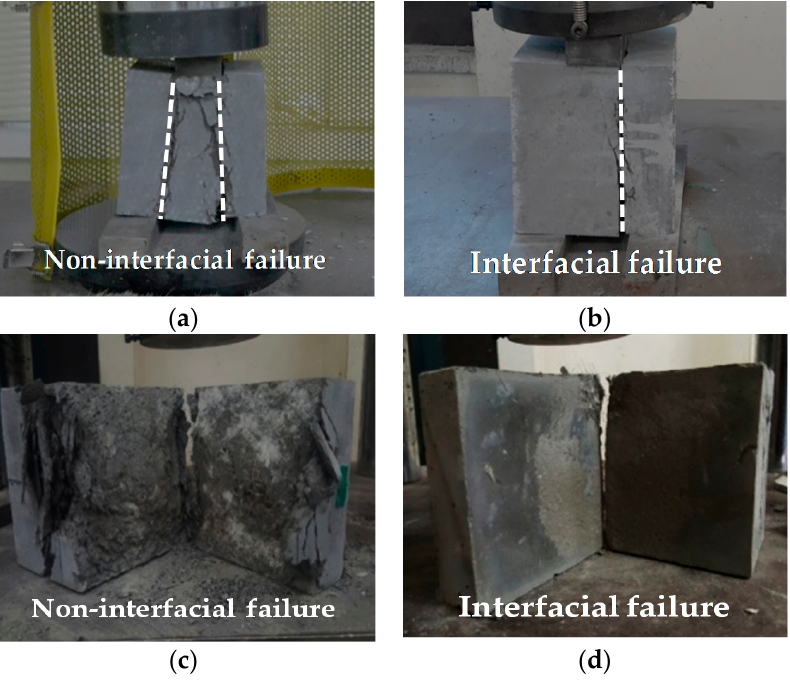
Figure 7. Failure modes: ( a ) non-interfacial failure; ( b ) interfacial failure; ( c ) cross-section of non-interfacial failure; and ( d ) cross-section of interfacial failure.